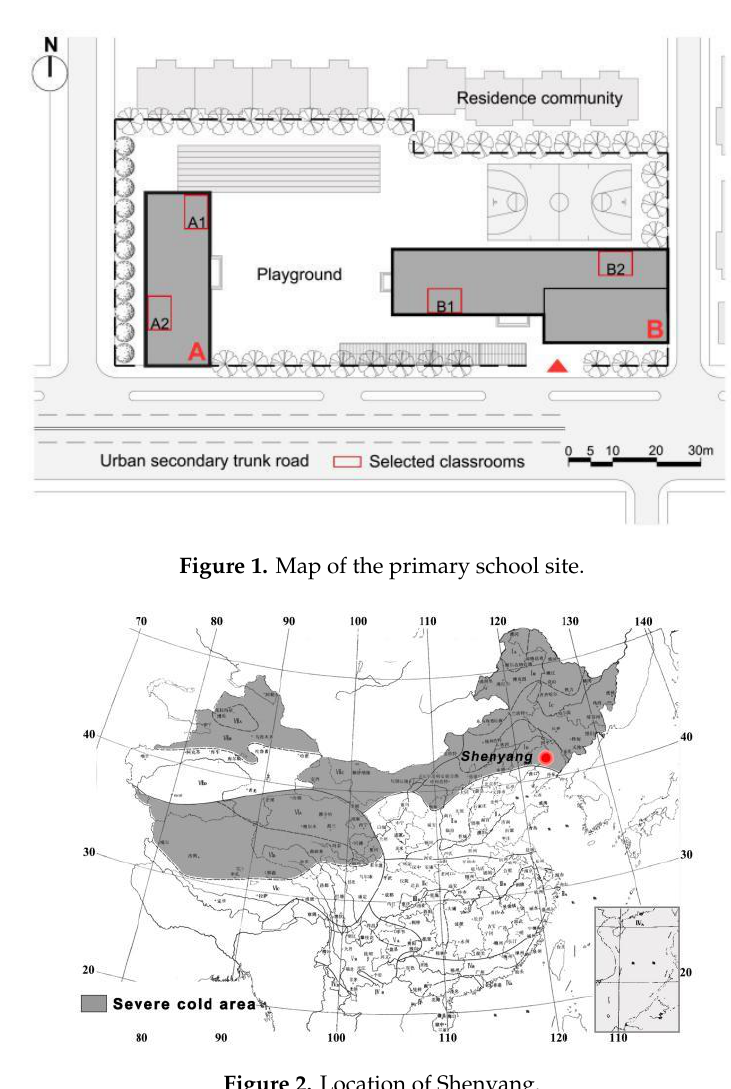
Figure 2. Location of Shenyang.